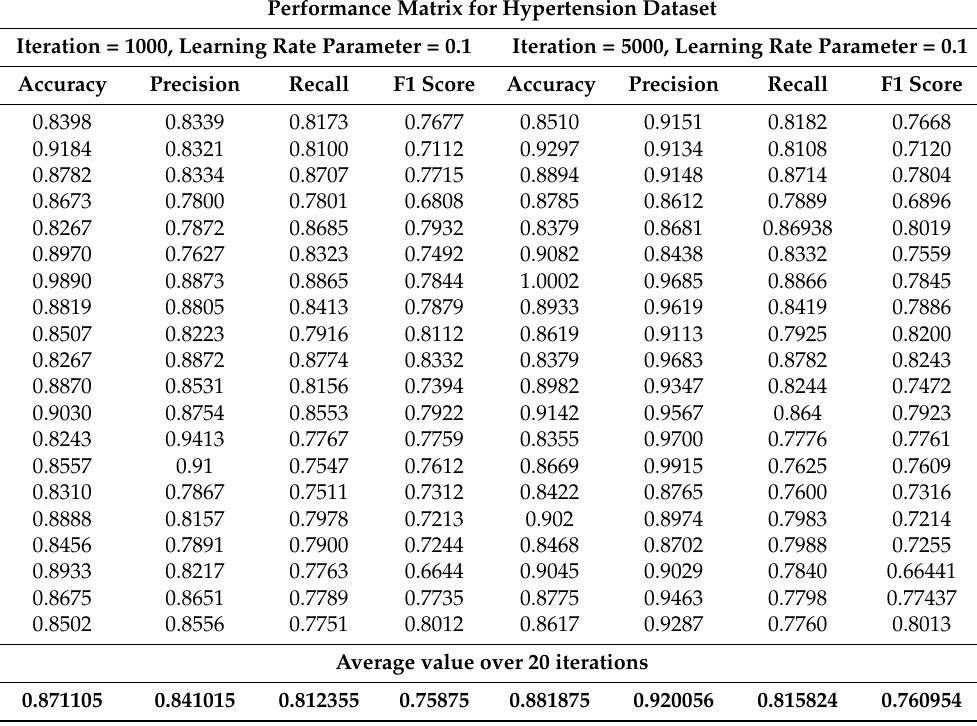
Table 7. Performance matrix of the hypertension risk assessment model. Performance Matrix for Hypertension